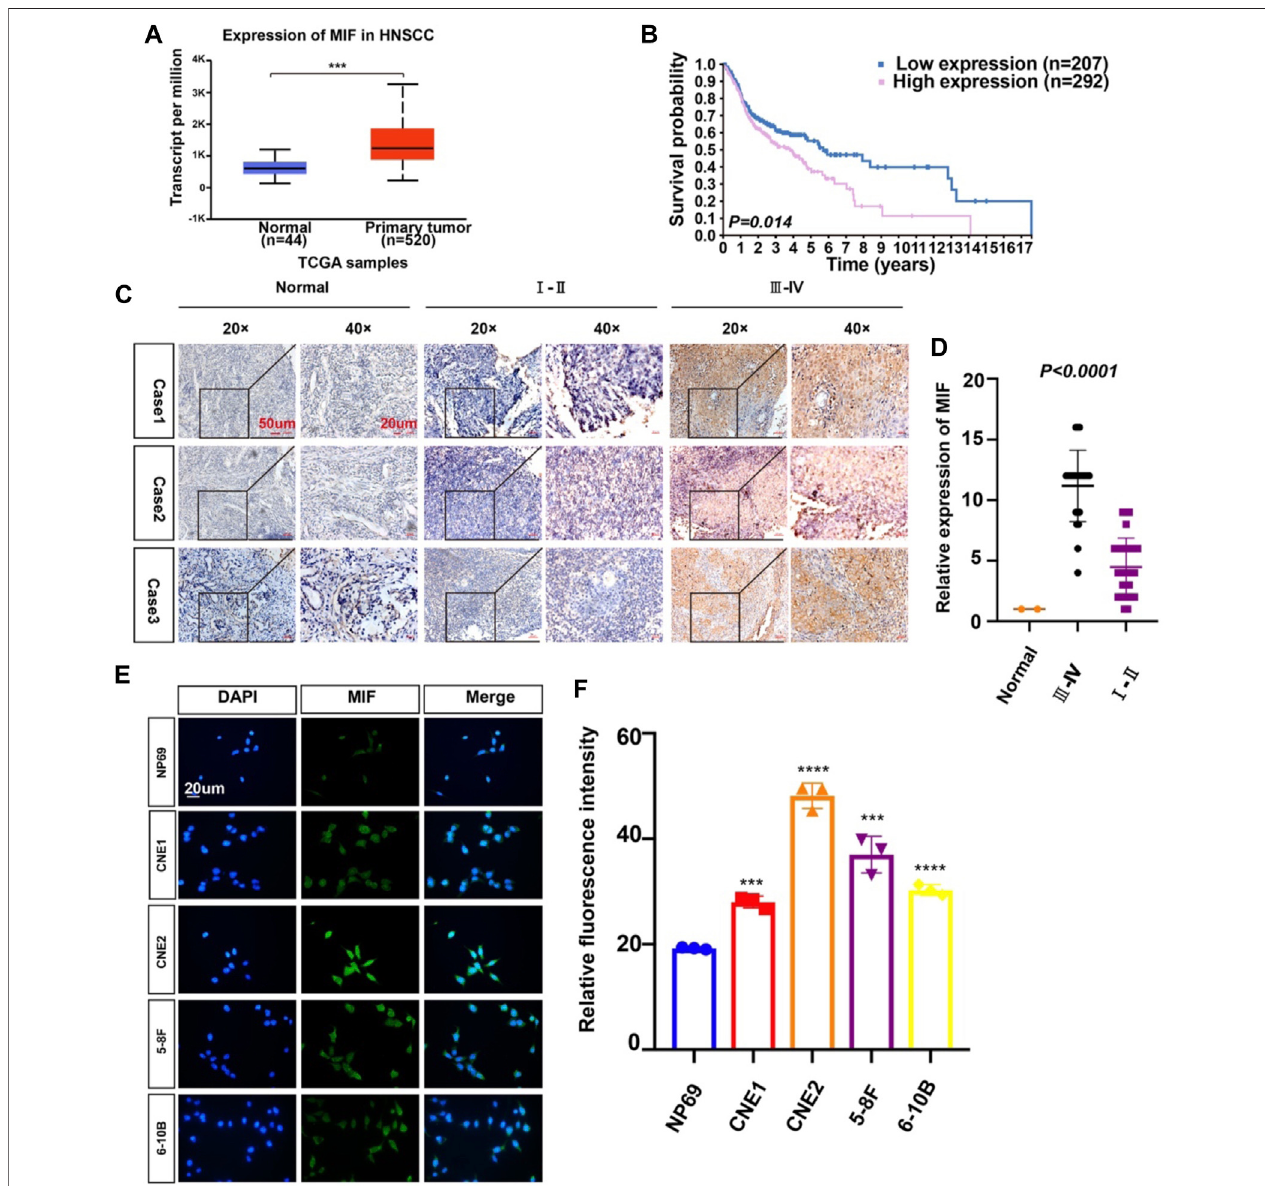
FIGURE 1 | MIF expression in human nasopharyngeal carcinoma is higher than that in normal tissues. (A) Statistical comparison of MIF expression across TCGA database, one-way ANOVA. (B) Statistical analyses of the association of MIF expression with the survival time of the patients. Log-rank test. (C) Immunohistochemical stainingofMIFinpatientspecimensofdifferentstages. (D) TheIHCstainingscoreofMIFinNPCtissueswasde fi nedaslowexpression(scoresof0 – 8)orhighexpression (scores of9 – 16) byX-tile Software. Then,Kaplan-Meier analysiswasused tocompare MIF IHC staining scoresofpatientsin different stages. eMIF levels inNP-69 and NPC cell lines were examined by IF (unpaired t-test). CNE-1, CNE-2, 5 – 8F, and 6 – 10B are human NPC cell lines; NP-69 is an immortalized normal nasopharyngeal epithelial cell line. Scale bar:20 um. f Statistics of fl uorescence intensity through ImageJ, unpaired t-test. All graphs show the mean ± SEM of at least three independent experiments. * p < 0.05, ** p < 0.01, *** p < 0.001.